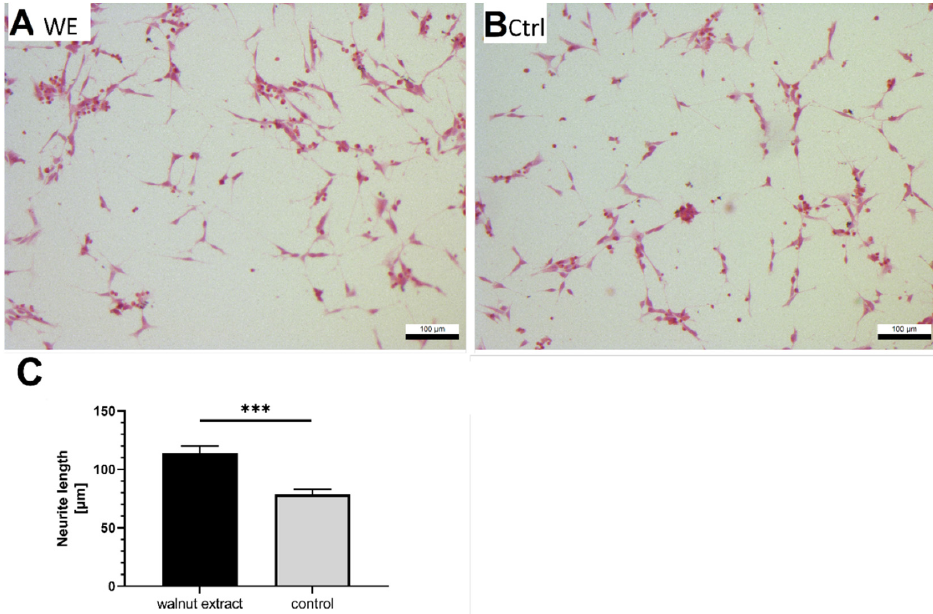
Figure 4. Effects of 10 µg/mL walnut extract (WE) in SY5Y-APP695 cells on neurite growth. EtOH- 12%BSA mixture served as control. ( A ) Microscopic view of SY5Y-APP695 cells differentiated with retinoic acid (10 µM) and 10 µg/mL WE. ( B ) Microscopic view of cells treated with retinoic acid (10 µM) and EtOH-BSA control (Ctrl). ( C ) Quantification of neurite length of differentiated SY5Y- APP695 cells treated with 10 µg/mL WE. Data displayed as means ± SEM; n = 6. For each n, at least 10 neurites were measured in 3 separate images. Significance (student’s t -test) is displayed as *** p < 0.001.